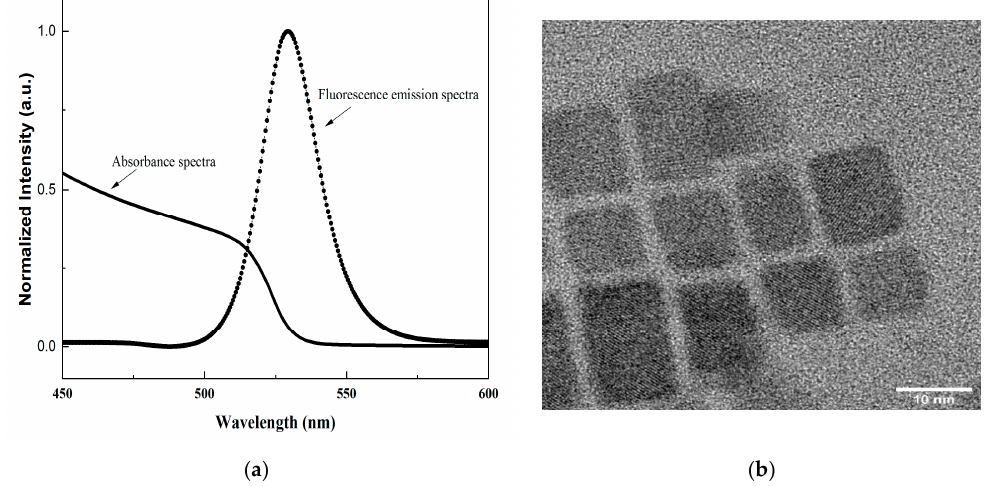
Figure 3. ( a ) UV–Vis absorption and PL spectra of FAPbBr 3 NCs. ( b ) TEM images of FAPbBr 3 NCs.